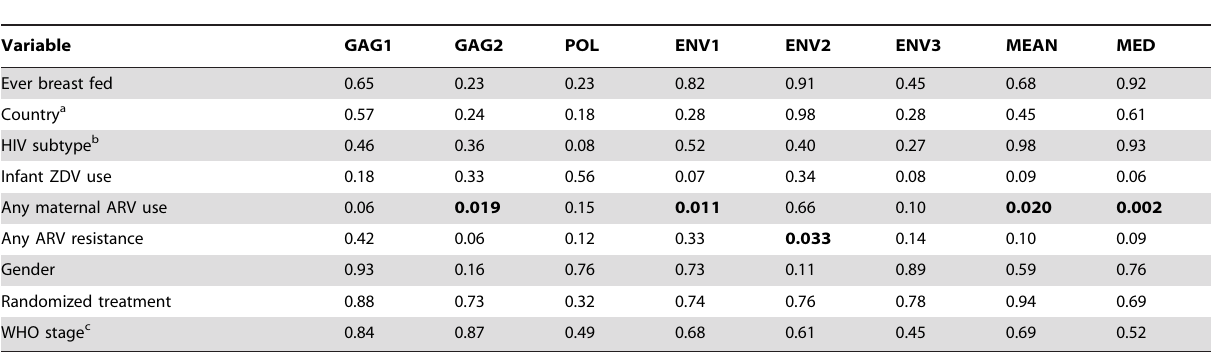
The table shows the statistical significance from Kruskal-Wallis tests of the association of baseline categorical demographic and clinical characteristics and HIV diversity scores. HRM scores were obtained for six regions of the HIV genome (see Methods); analyses were also performed for the mean (MEAN) and median (MED) of all six HRM scores. P values , 0.05 are bolded. Abbreviations: ZDV: zidovudine; ARV: antiretroviral; WHO: World Health Organization. a Country: South Africa vs. other